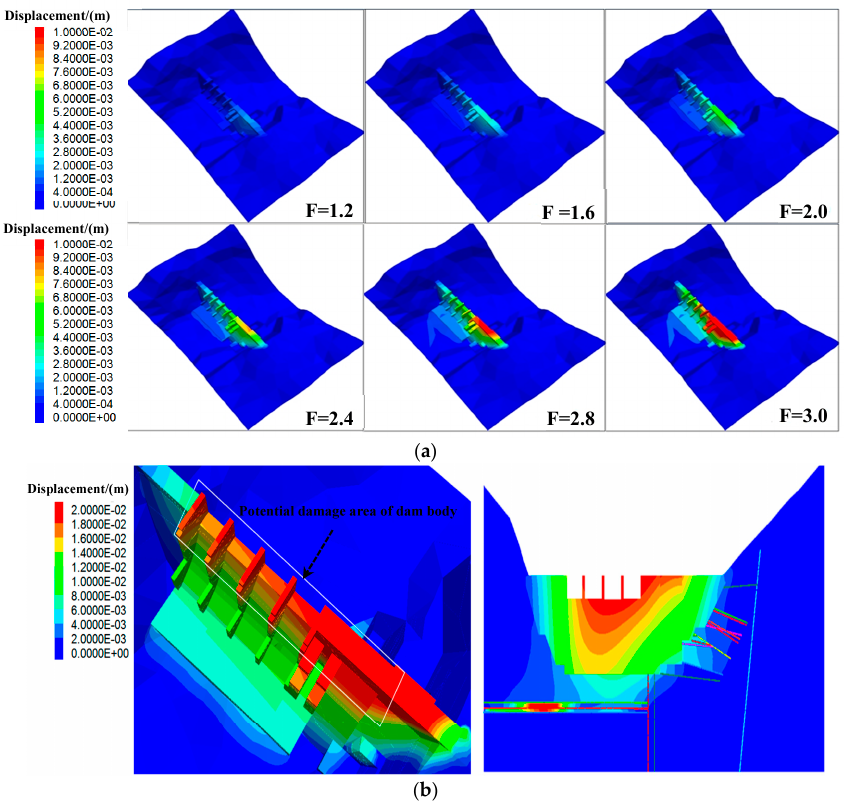
Figure 8. ( a ) Distribution characteristics of deformation of dam body with displacement during flood stage ( b ) Deformation distribution of dam foundation and section 1-1 (strength reduction is 3.00).